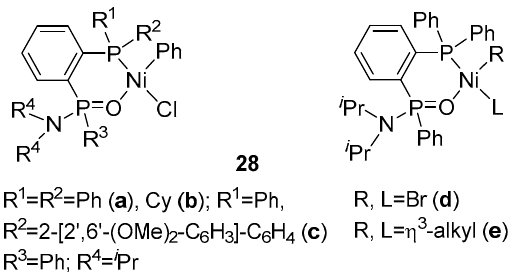
Figure 25. Nickel catalysts 28a – e based on phosphine phosphonic amide ligands.